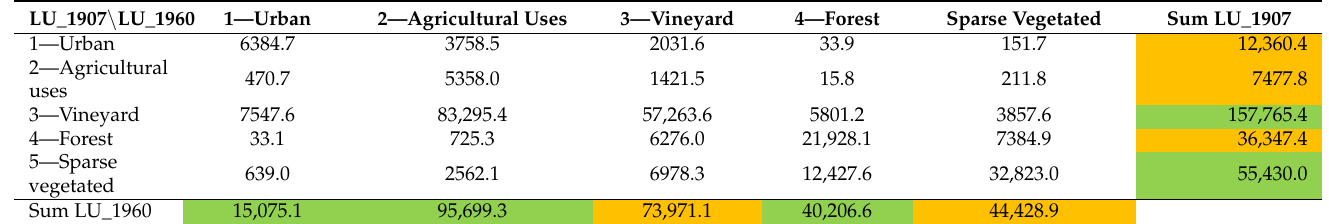
Table 7. Contingency table of land cover change for the period 1907–1960. Results represent the areas under change and are expressed in ha. Cells in orange report a loss in ha, while green ones report a net gain in ha.